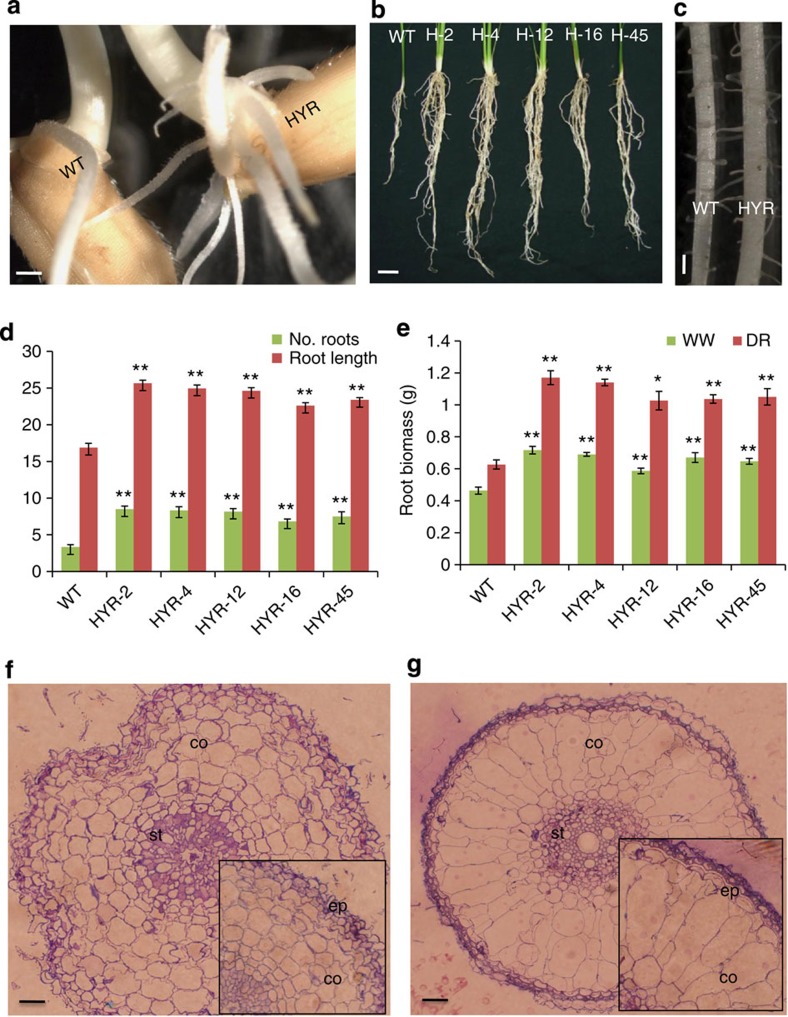
Root phenotype and response of HYR lines.(a) Adventitious root phenotype of HYR (HYR-4) line and WT grown on nutrient-free medium for 7 days; scale bar, 1.5 mm. (b) Root morphology of WT and five HYR lines grown for 30 days in sand supplemented with Hoagland’s solution; scale bar, 2 cm. (c) HYR line (HYR-4) showing thicker roots compared with WT, photographed under light microscope; scale bar, 2 mm. (d) Quantification of HYR and WT root phenotypes shown in b, with the number of adventitious roots and the root length (cm), represented by mean±s.e. (n=6). (e) Root biomass analysis of WT and HYR lines under well-watered and drought-stress conditions in soil. Values are means±s.e. of (n=6 of each genotype), with significance shown (t-test; *P≤0.05; **P≤0.01). (f,g) Root ultrastructure of HYR lines shown by sections (1 cm above tip) of WT (f) and HYR (g), at low ( × 20) and high ( × 40, inset) magnification under light microscope; scale bar, 150 μm. The prominent structure of enlarged cortex (co), stele (st) and epidermis (ep) are seen in HYR root sections (g).